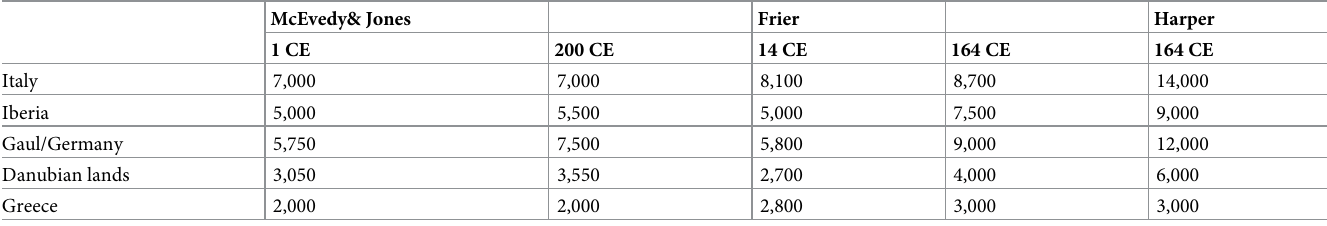
Table 2. Population estimates for the Roman empire, by European region (thousands).